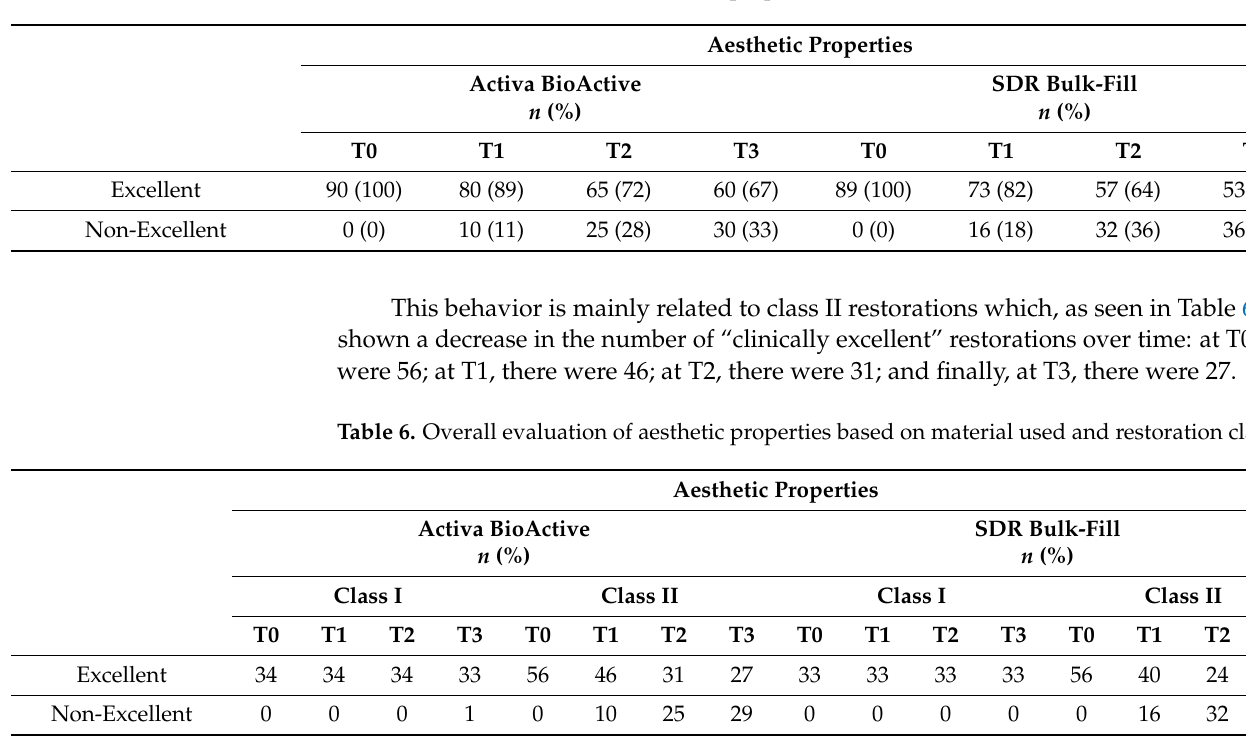
Table 5. Overall evaluation of aesthetic properties of restorations based on material used.